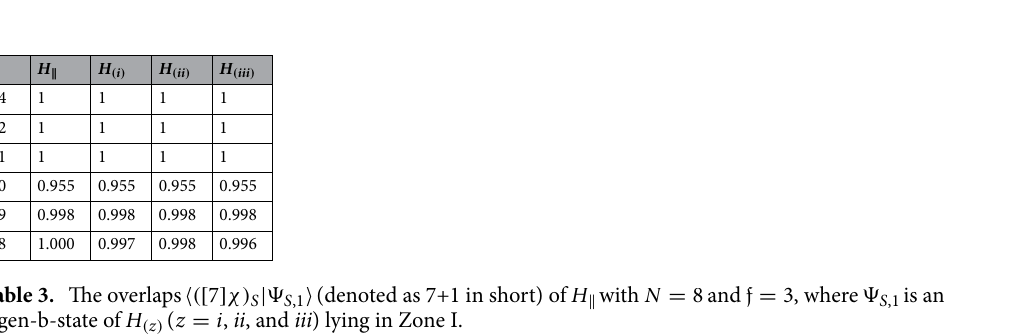
Figure 5. The spectra of an 8-body system with spin-3 trapped cold atoms. ( a ), ( b ), and ( c ) are for the Hamiltonian H ( i ) , H ( ii ) , and H ( iii ) respectively.